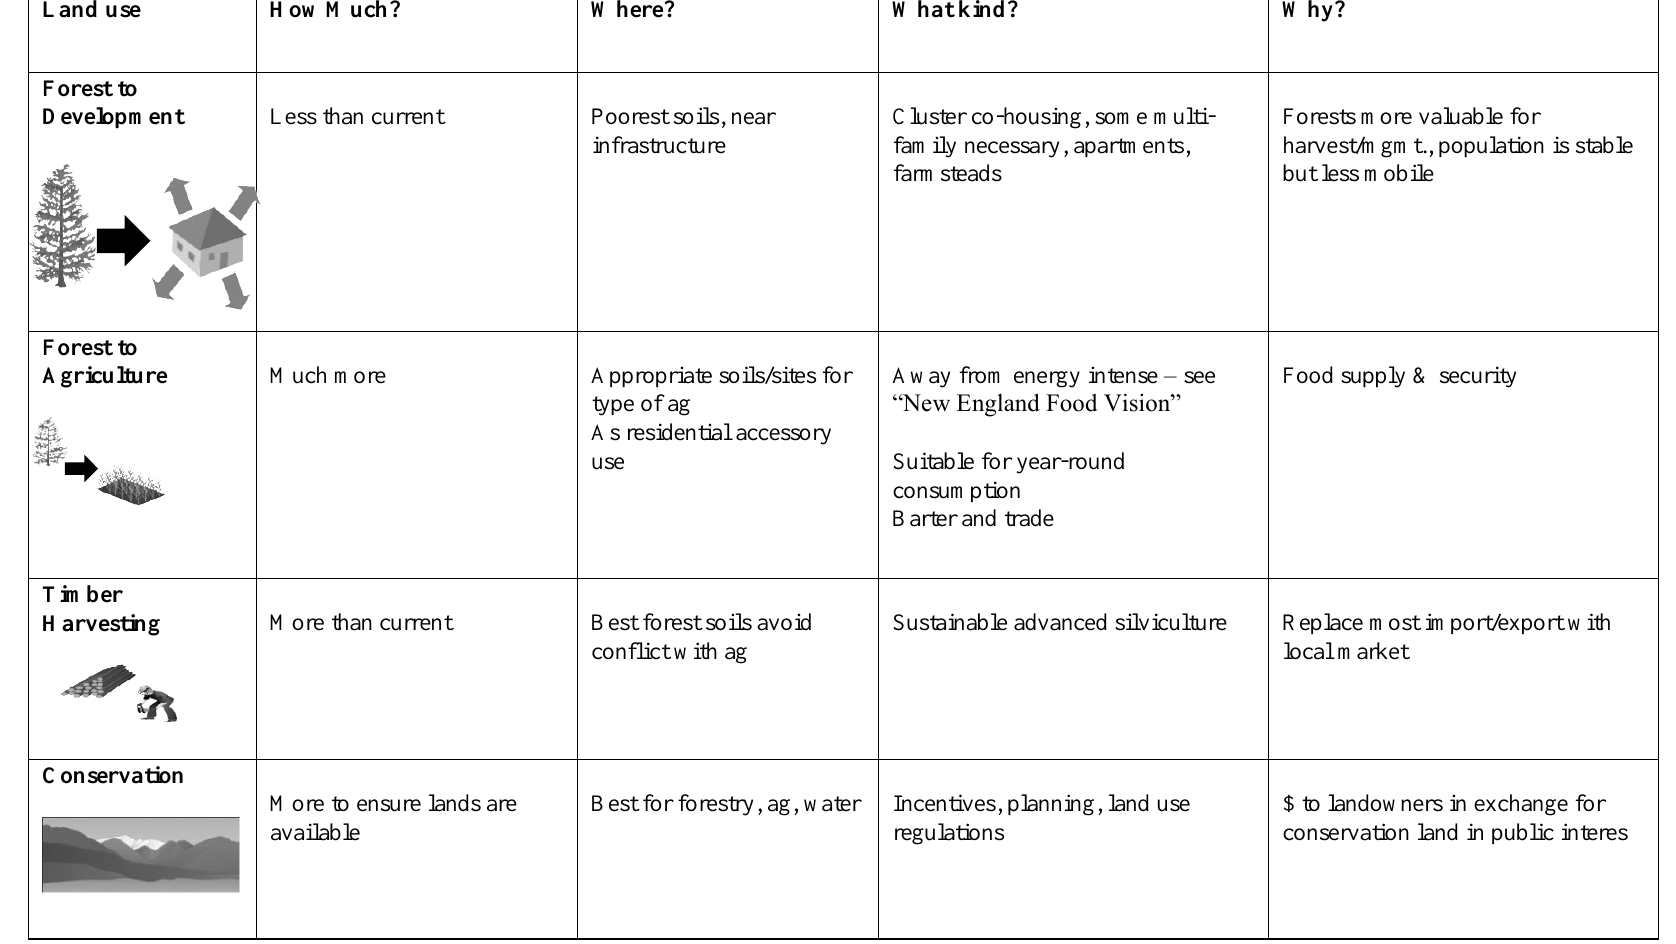
Table A2.7. Scenario 3: